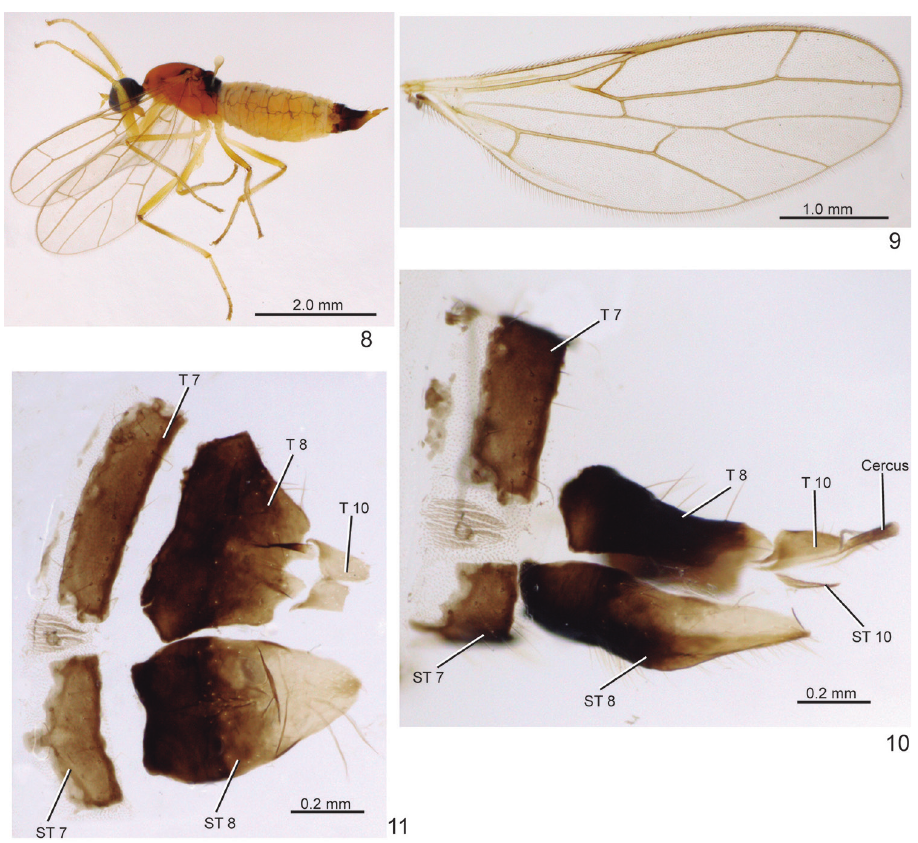
Figures 8–11. Metachela danitakiyae sp. n., paratype female from Itatiaia. 8 Habitus, lateral view 9 Wing 10 Segments 7-11, lateral view 11 Tergites 7, 8, and 10, dorsal view, sternites 7 and 8, ventral view. Legs (Fig. 1): Yellow, except fore tibia with narrow anteroventral brown stripe dis- tally, and hind femur at distal 2/3 and tarsomeres 4–5 brown. Fore coxa as long as distance between fore- and mid coxae, 4× as long as wide, with some dorso-apical pale setae. Fore femur approximately 1.3× as long as fore coxa, 4.5× as long as wide, with anteroventral row of 3–5 spines, anteroventral row of 6–8 denticles, and posteroventral row of 18–20 denticles, with basal ones stouter; anteroventral row of denticles placed on distal half and posteroventral row restricted to distal 0.9, and both rows without apical discontinuity and diverging at apex. Fore tibia approximately 0.8× as long as fore femur; with decumbent short pale bristles dorsally, more densely distributed apically. Mid fe- mur with two anteroventral and 12 posteroventral spines, basal pair stouter. Hind legs slender, with fine setae, except hind tibia with dorsoapical comb of short setae. Wings (Fig. 2): Membranous, veins yellowish; vein R short, fused to vein R ; R 2+3 1 4+5 fork angle around 70°; R and M slightly divergent at extreme apex; cell bm+dm ending 5 1 beyond apex of R , ~1.3× as long as cell br; cup cell closed. Halter whitish 1